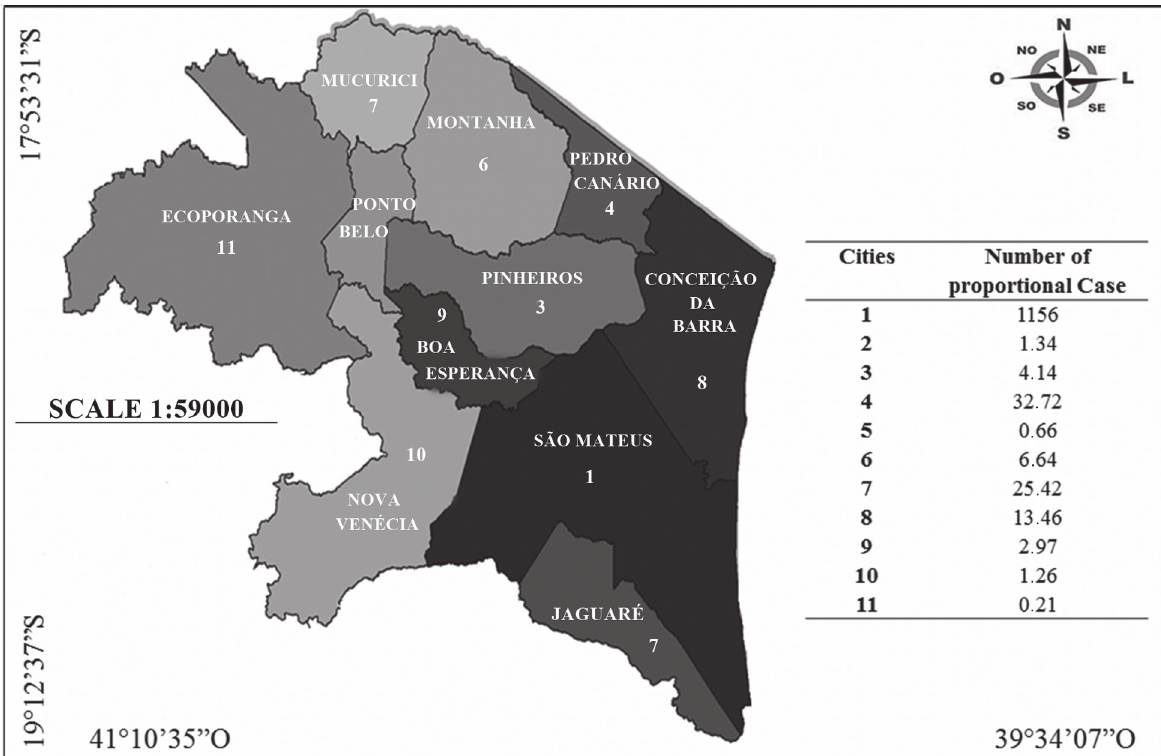
Figure 1 - Map of the northern region of the Espírito